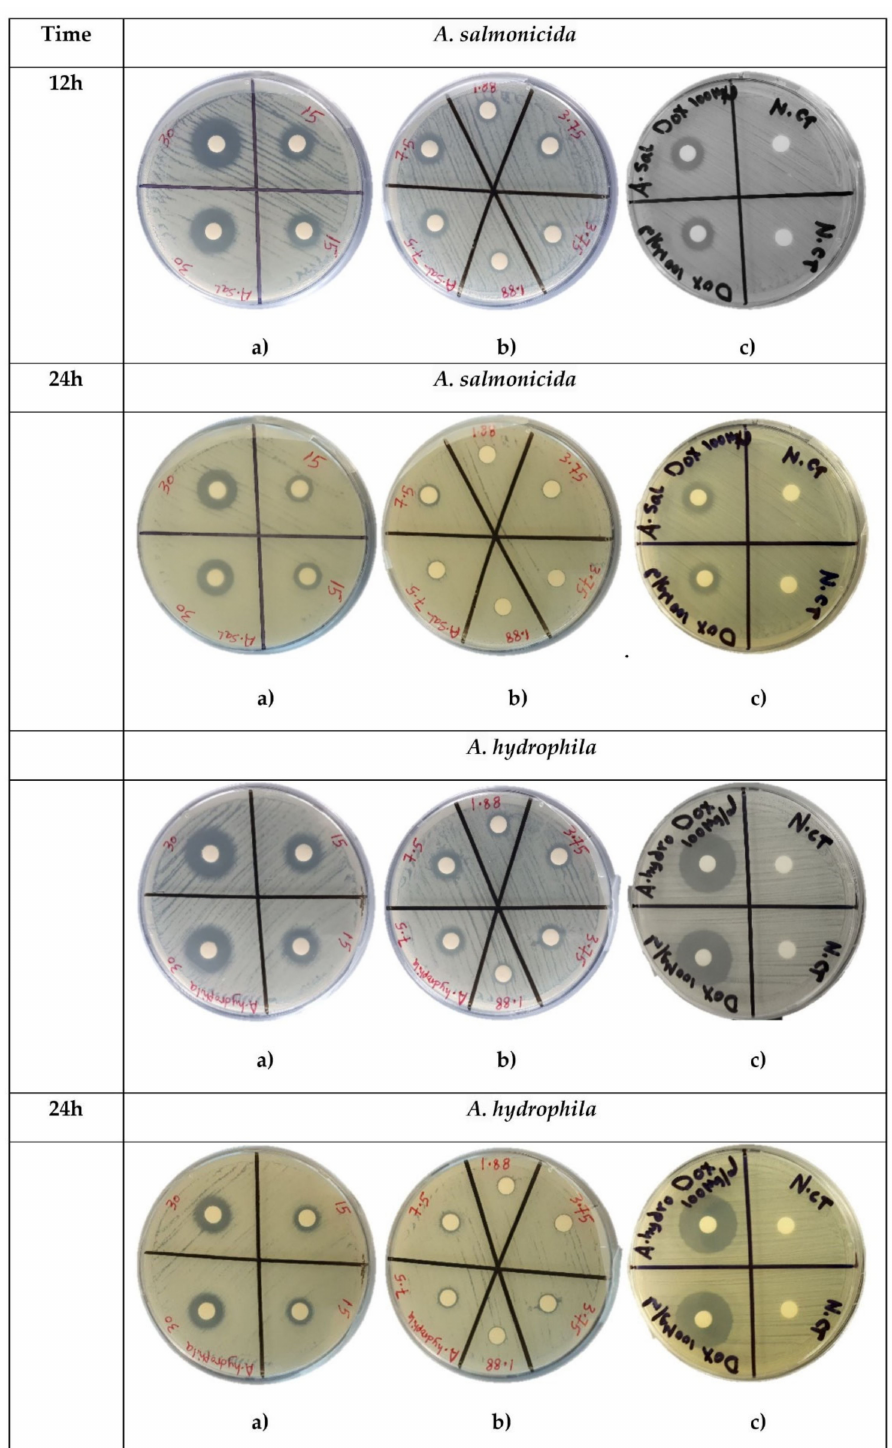
Figure 4. Dose-dependent susceptibility of A. hydrophila and A. salmonicida determined by disk diffusion assay of the AWME3. ( a , b ) IZD formed around the disks loaded with AWME3 at tested con- centrations in the range of 1.88–40 mg/mL after 12 h and 24 h of incubation; ( c ) Positive control (Doxy- cycline 100 µ g/mL) and negative control (extraction solution of AWM mixture, N.ct) determined at 12 h and 24 h of incubation. Mean IZD for each condition recorded in three independent